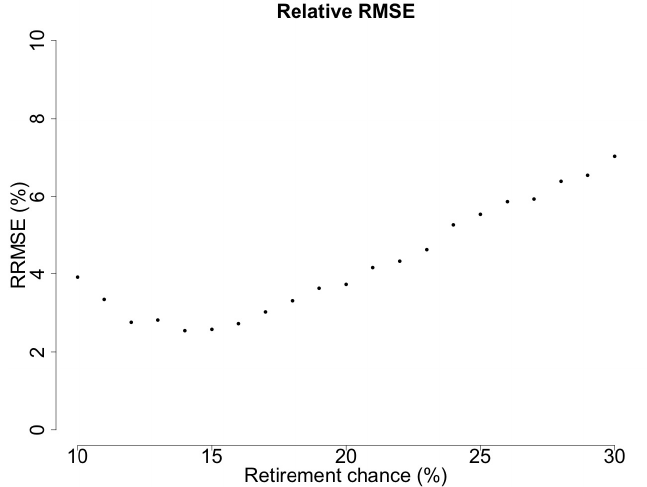
Figure 8. Calibration through the relative root mean square error (RRMSE) for different percentages of retirement after legal retirement age.